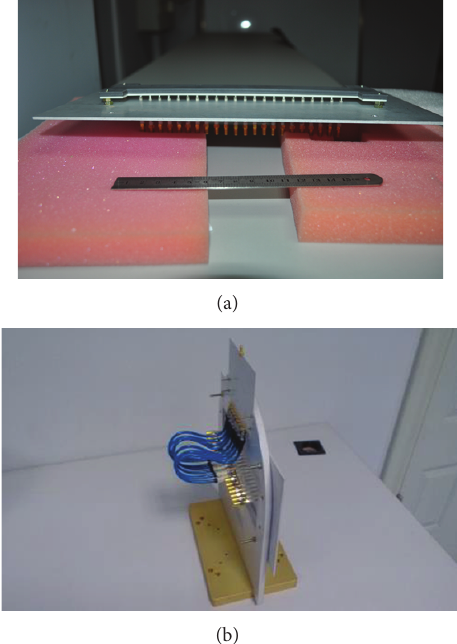
Figure 3: Prototype planar phased array antenna. (a) Array antenna and (b) Array antenna with the power